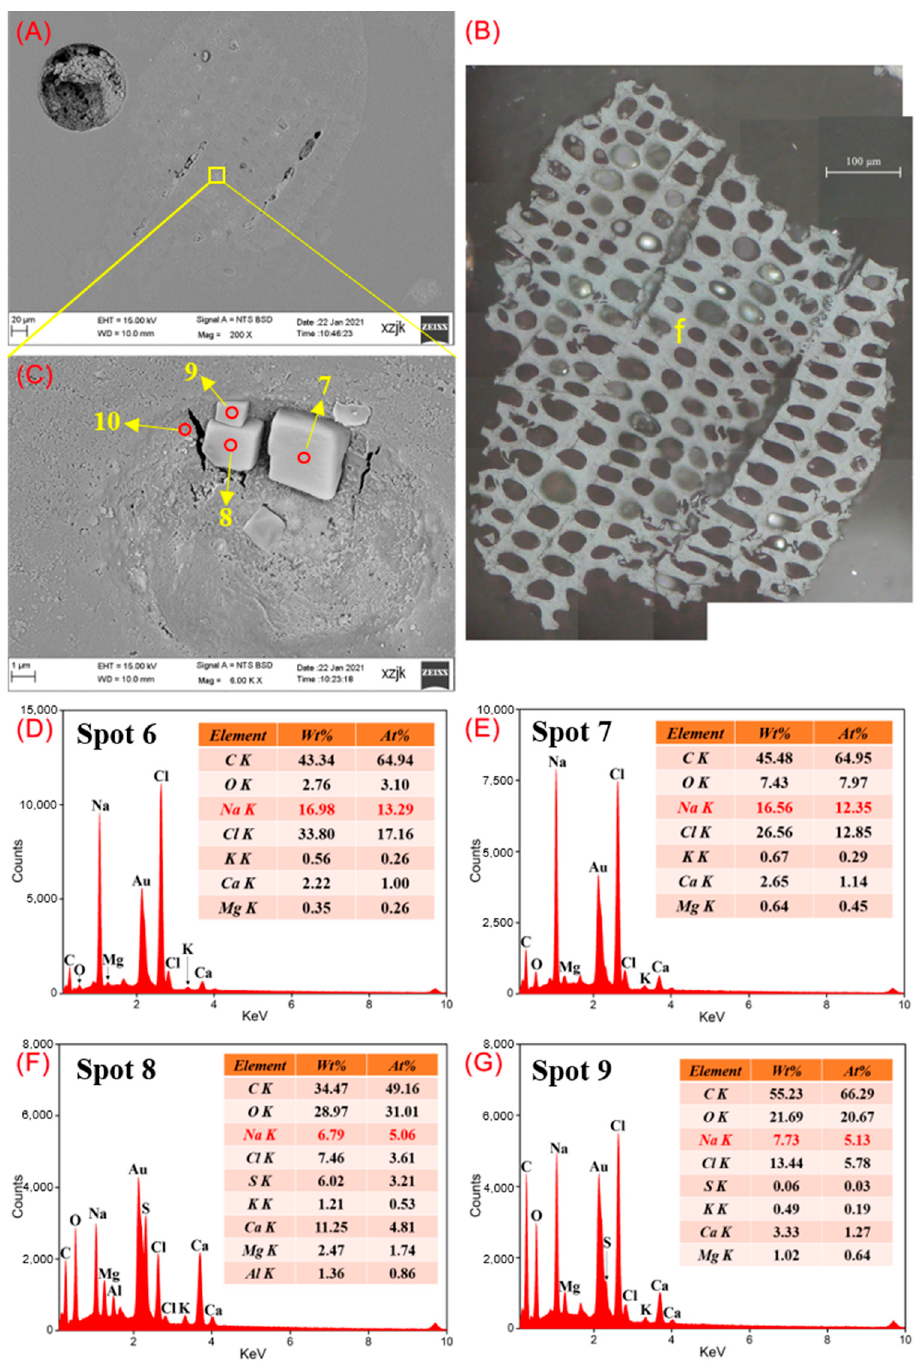
Figure 9. Microscope and SEM–EDS identification of YHI: ( A ) SEM image of ( B ); ( B ) A fusinite (f) particle; ( C ) Magnified SEM image of the cell boxed in yellow in ( A ); ( D – G ) EDS spectra from Spots 6, 7, 8, and 9, respectively.